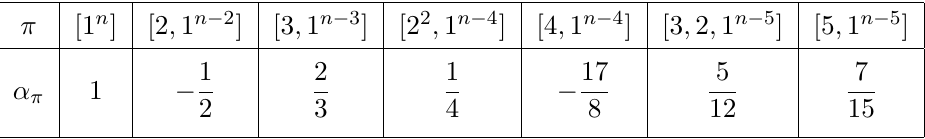
Table 1 . First few values of α π for the finest